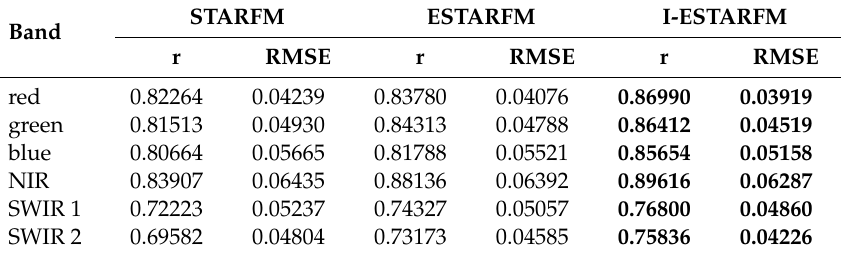
Table 4. Accuracy assessment results of study area